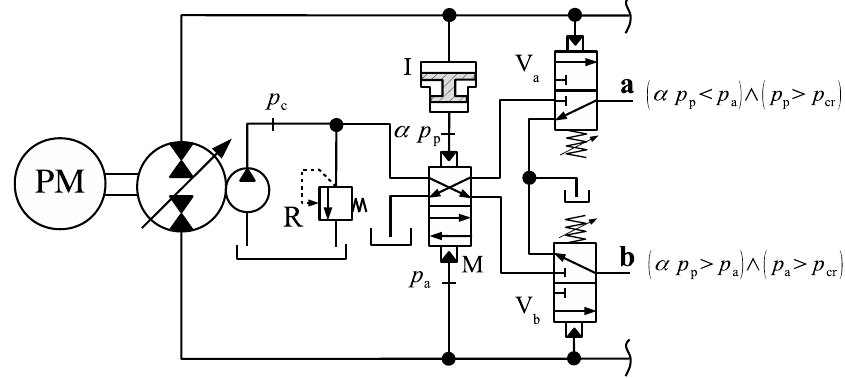
Figure 28. Circuit for triggering the compensation flows.